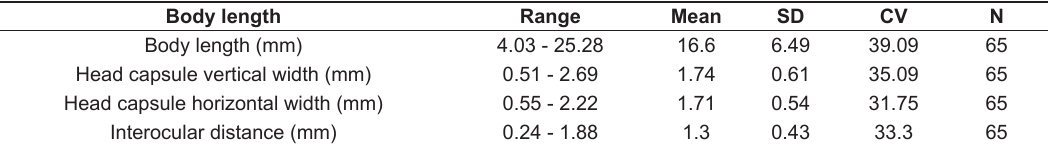
Table 1. Range, mean, standard deviation (SD), coefficient of variation (CV = (SD / mean)*100, in 100%) and number of observations (N) for body dimensions and body mass of Leptonema larvae from Taboões stream.